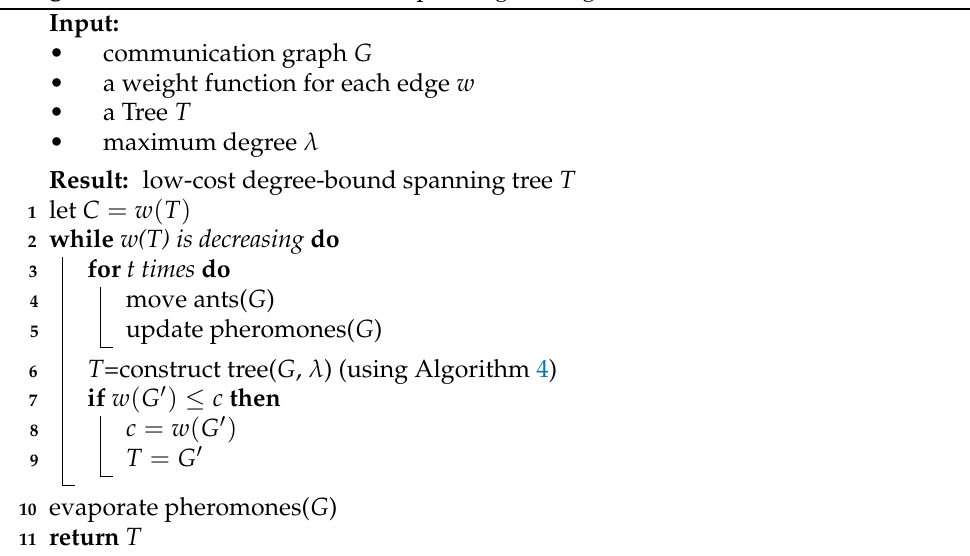
Algorithm 3: Move ants and build spanning tree algorithm.